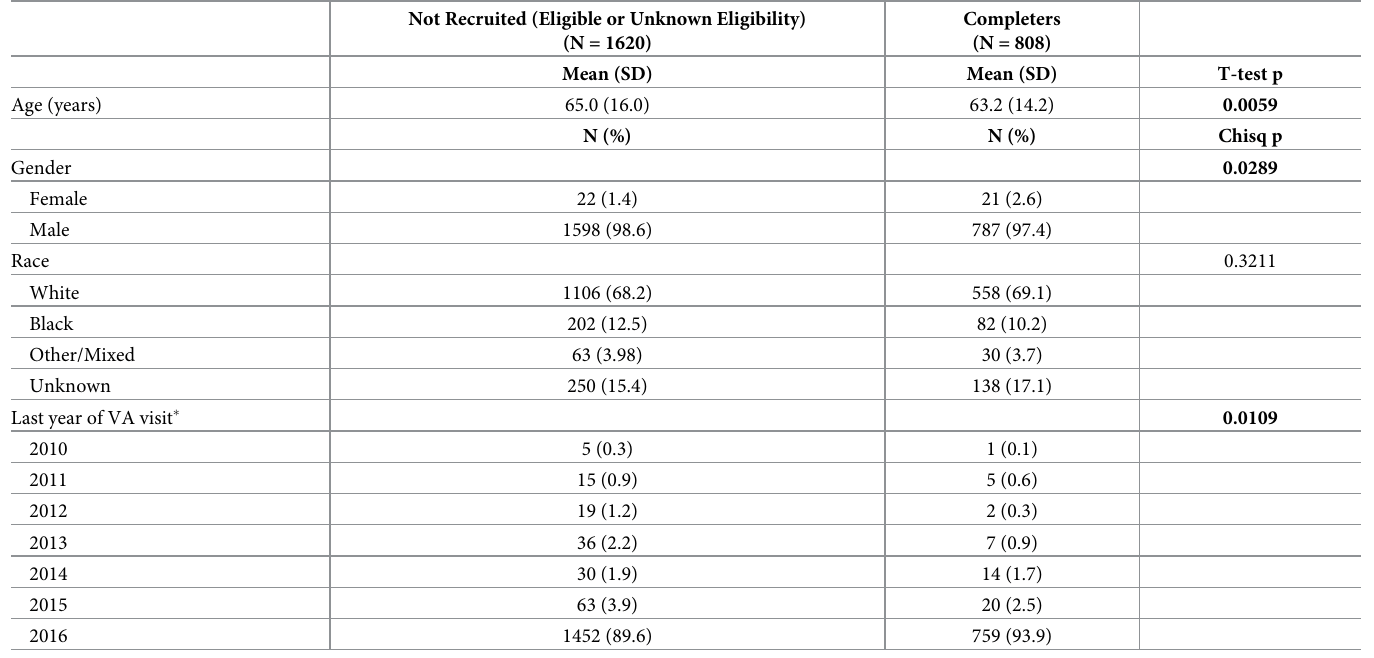
Table 1. Comparison of survey respondents and